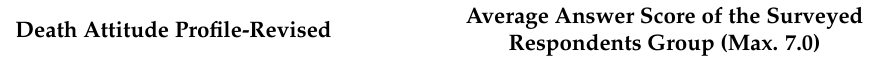
Table 3. The mean scores of the surveyed group of respondents for each scale of the DAP-R-PL questionnaire.